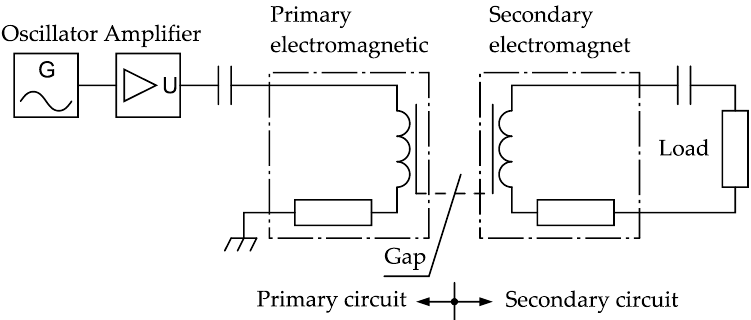
Figure 8. Equivalent circuit diagram of AC magnetic suspension system with power transmission using magnetic resonant coupling. The equivalent circuit of the primary electromagnet and the secondary electromagnet are represented in the dash–dot rectangles. The electromagnets are assumed as a series-connected inductance and equivalent resistance. The dashed line represents the coefficient of magnetic coupling that is a function of the gap.